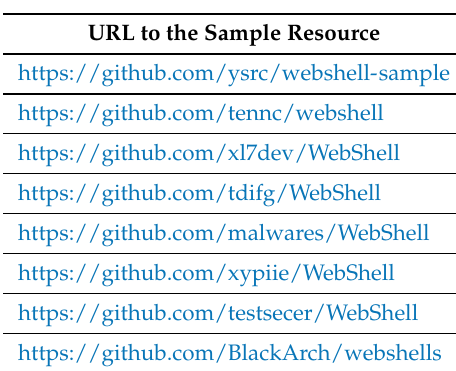
Table 2. Webshell sample sources.